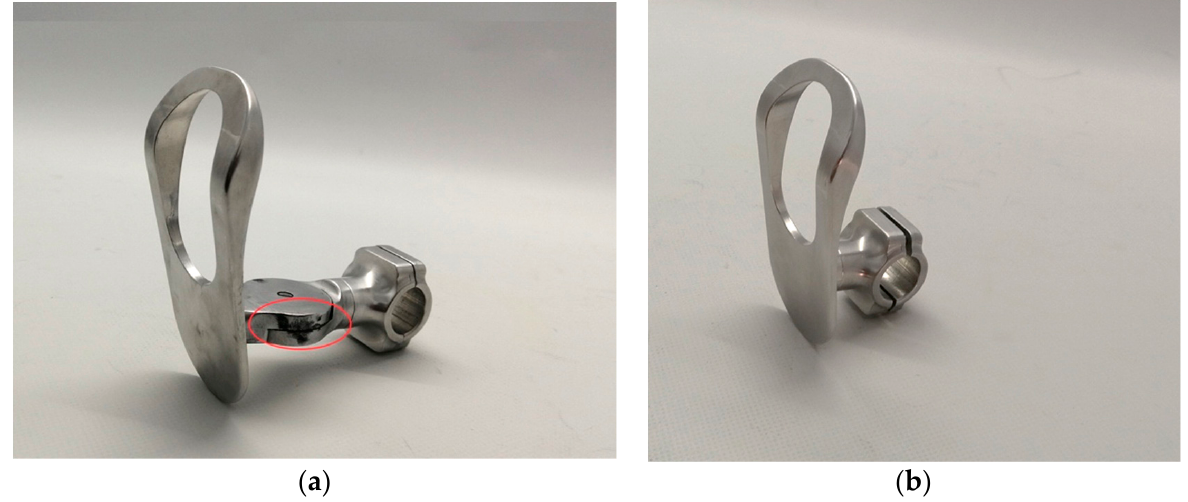
Figure 13. Examples of the models after experimental tests: ( a ) dynamic Model; ( b ) static Model.